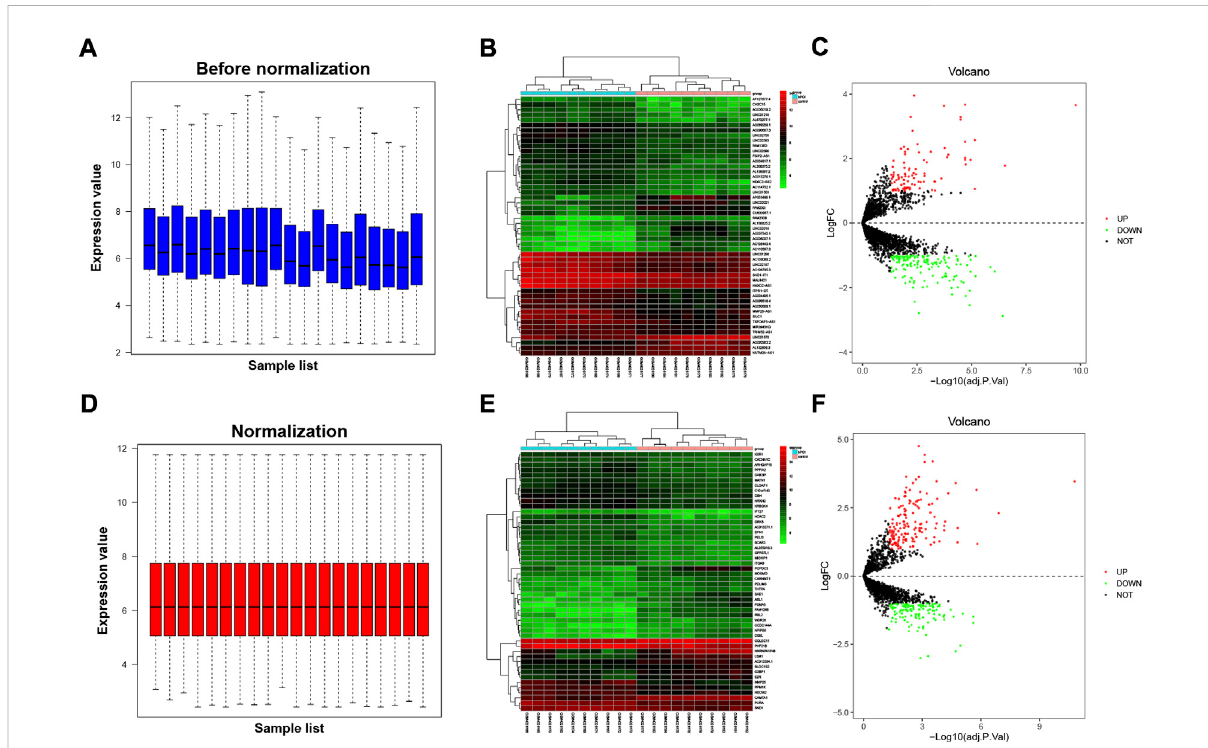
FIGURE 1 Differentially expressed lncRNAs and mRNAs from granulosa cells in patients with premature ovarian insuf fi ciency (POI). The dataset was split into the lncRNA dataset and protein-coding dataset. Microarray data of dataset, (A) prior to normalization and (B) following normalization. (C) Heatmap of top 50 DELs (sorted by adjusted p -value); (D) heatmap of top 50 DEGs (sorted by adjusted p -value). Volcano plot showing differentially expressed lncRNAs (E) and mRNAs (F) after being screened by FDR < 0.05 and log2|fold change| > 1. Red dots and green dots referred to the upregulated and downregulated genes,